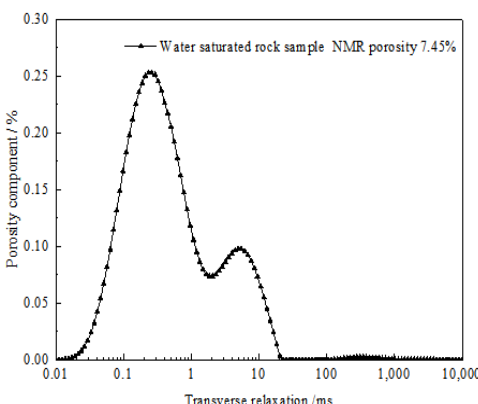
Figure 9. NMR T 2 spectrum of water-saturated rock sample (single peak to double peak).